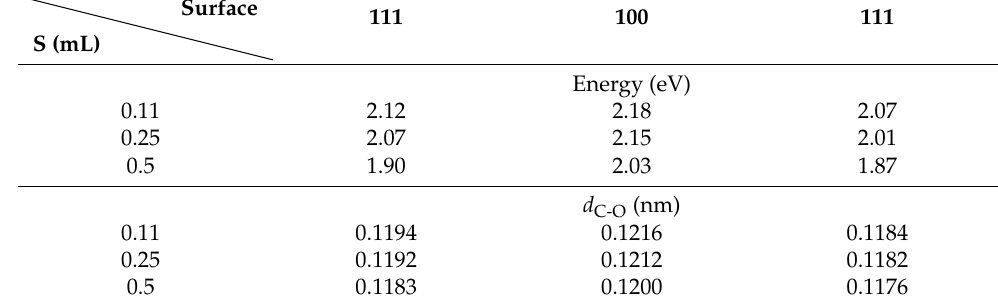
Table 3. Adsorption parameters of CO adsorption on three surfaces at different coverage levels.